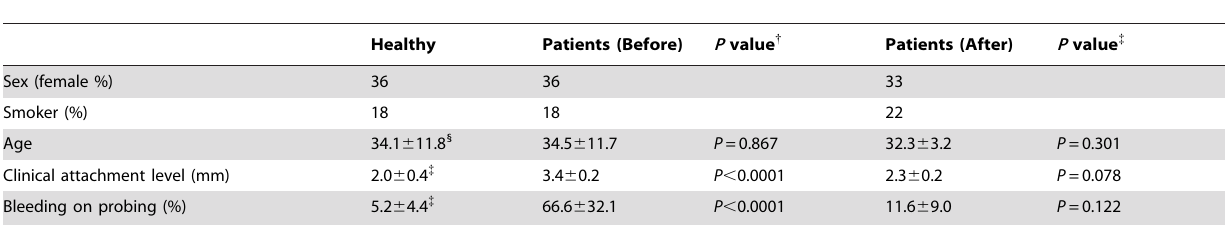
Table 1. Characteristics and clinical parameters of subjects.